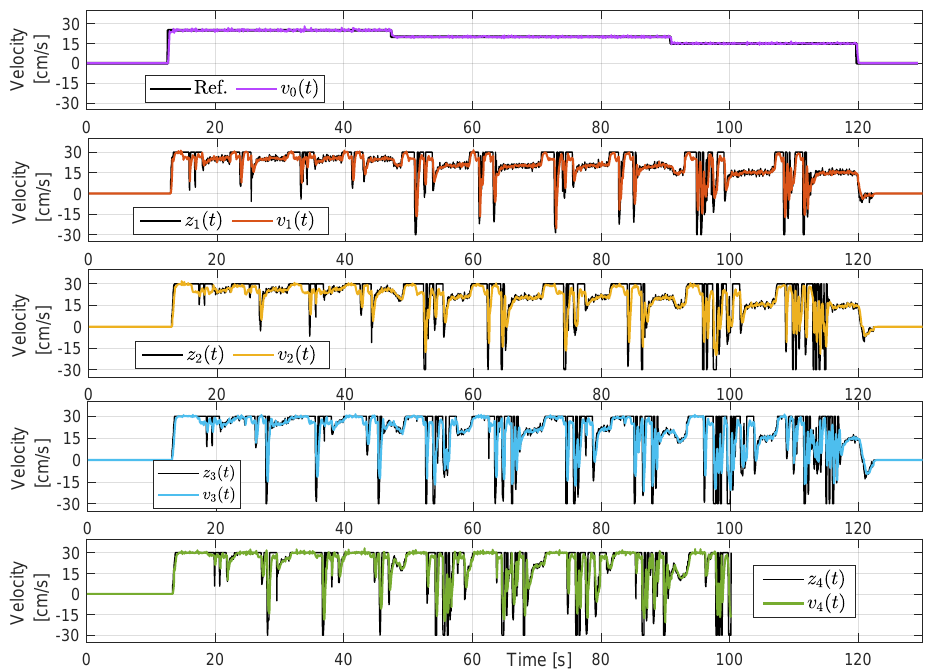
Figure 8. Velocity tracking using the non-cooperative strategy.